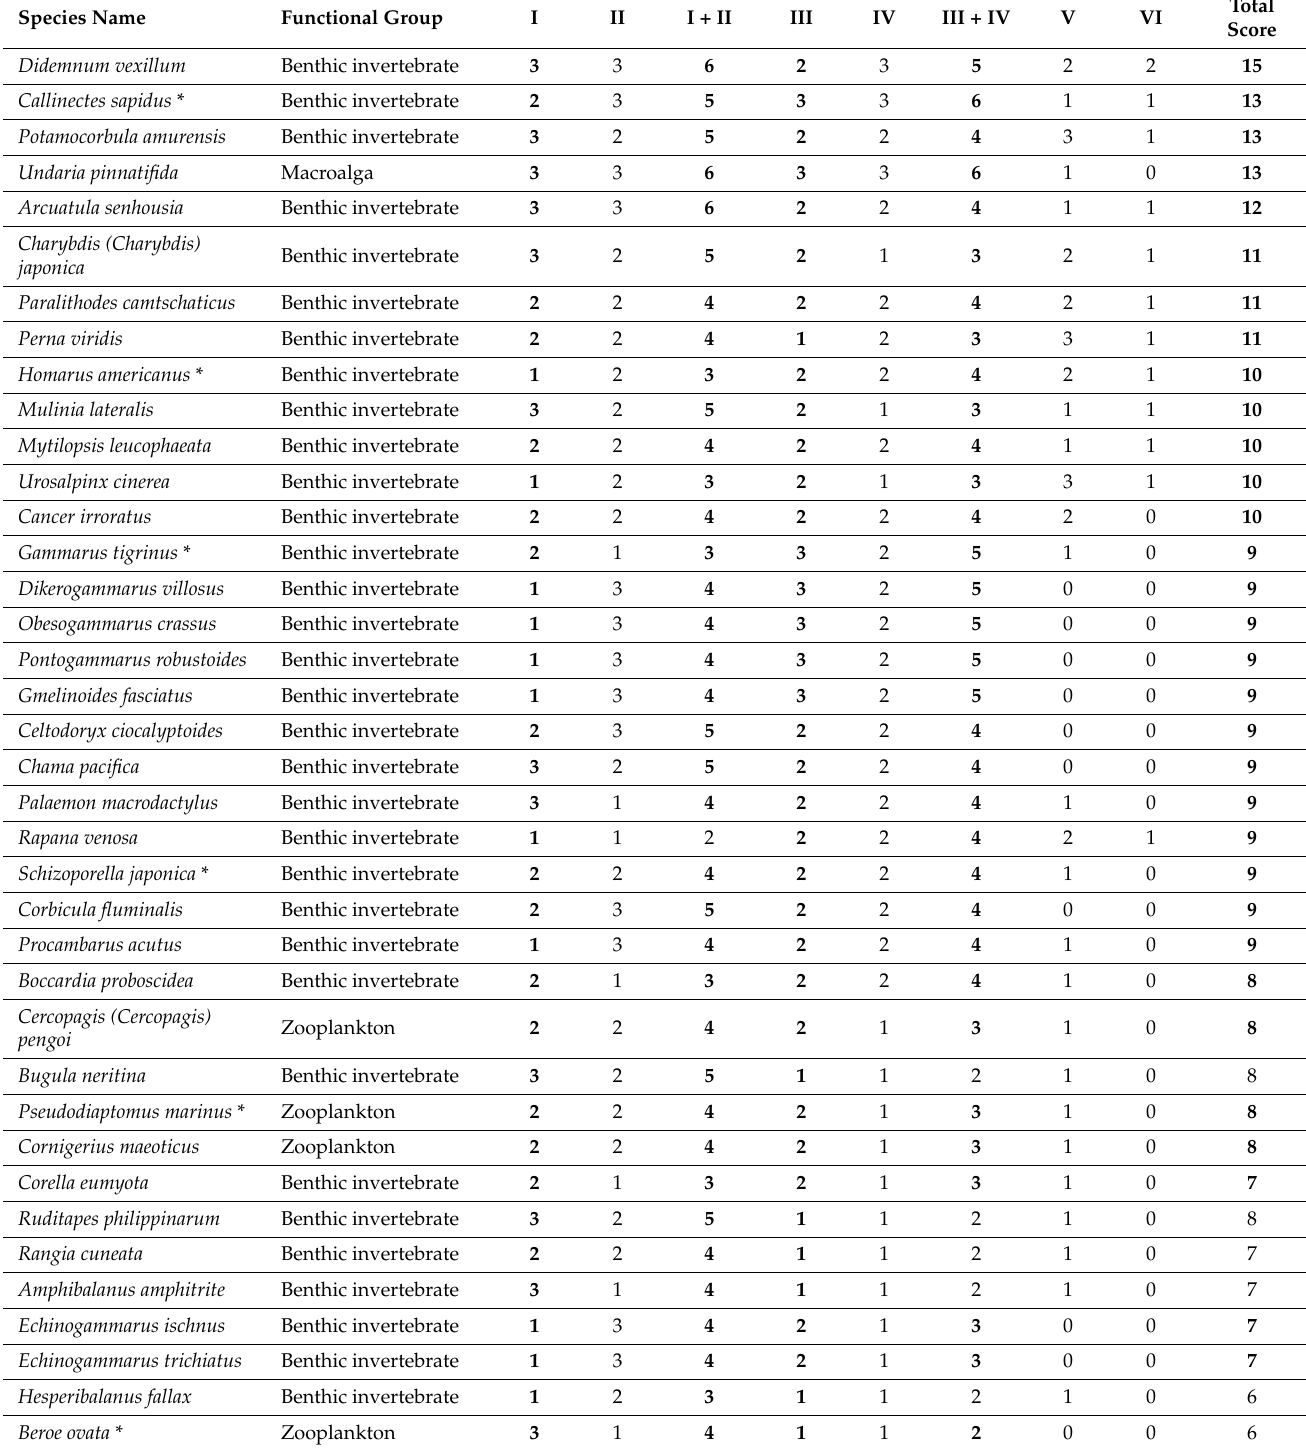
Table 2. Expert scores for horizon-scan marine species. *—these species have been found a few times, but are apparently not established. I—dispersal potential; II—conservation value of habitat; III—impact on native species; IV—impact on ecosystem functions; V—economic impacts; VI—health impacts. I and III must be >0, and I + II and III + IV must be ≥ 3. Scores fulfilling these criteria are in